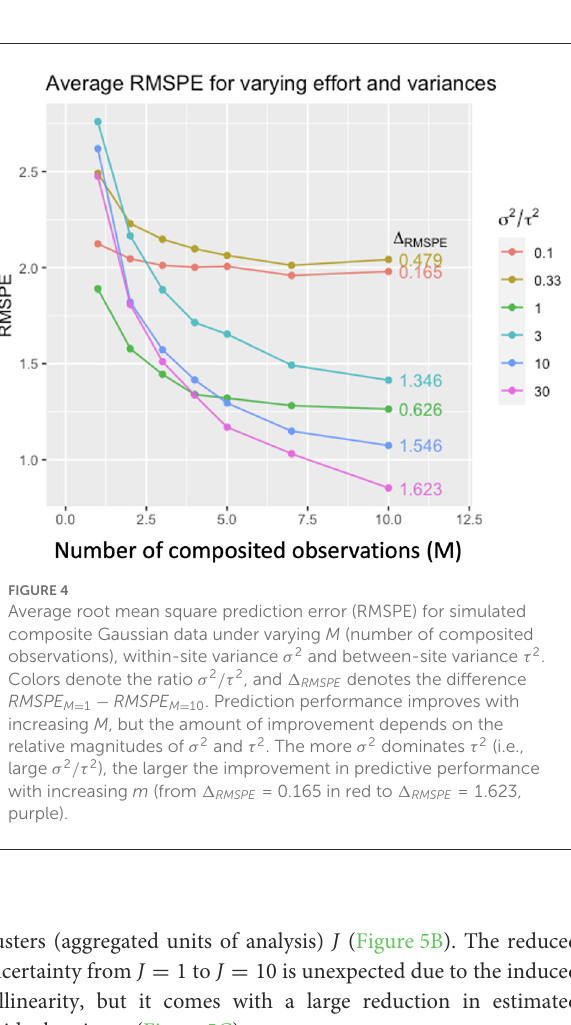
clusters (aggregated units of analysis) J (Figure 5B). The